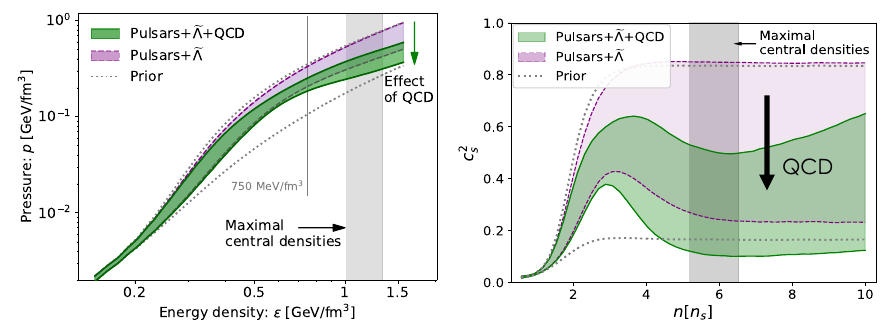
Figure 4. The impact of the QCD input to the equation-of-state inference. (Left)The previously ob- served kink structure in the reduced equation of state around 750MeV / fm 3 appears when the QCD input in included. (Right) The kink feature represents it self as a peak in the speed of sound. It becomes visible only after the QCD input is